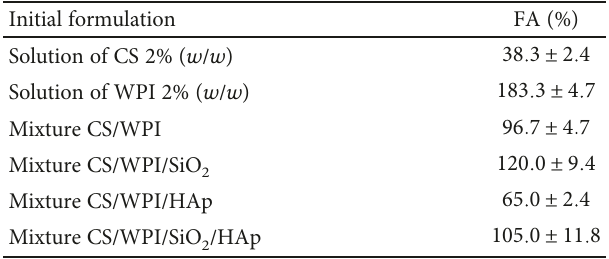
Table 3: Properties of liquid foams obtained in the batch process. Initial